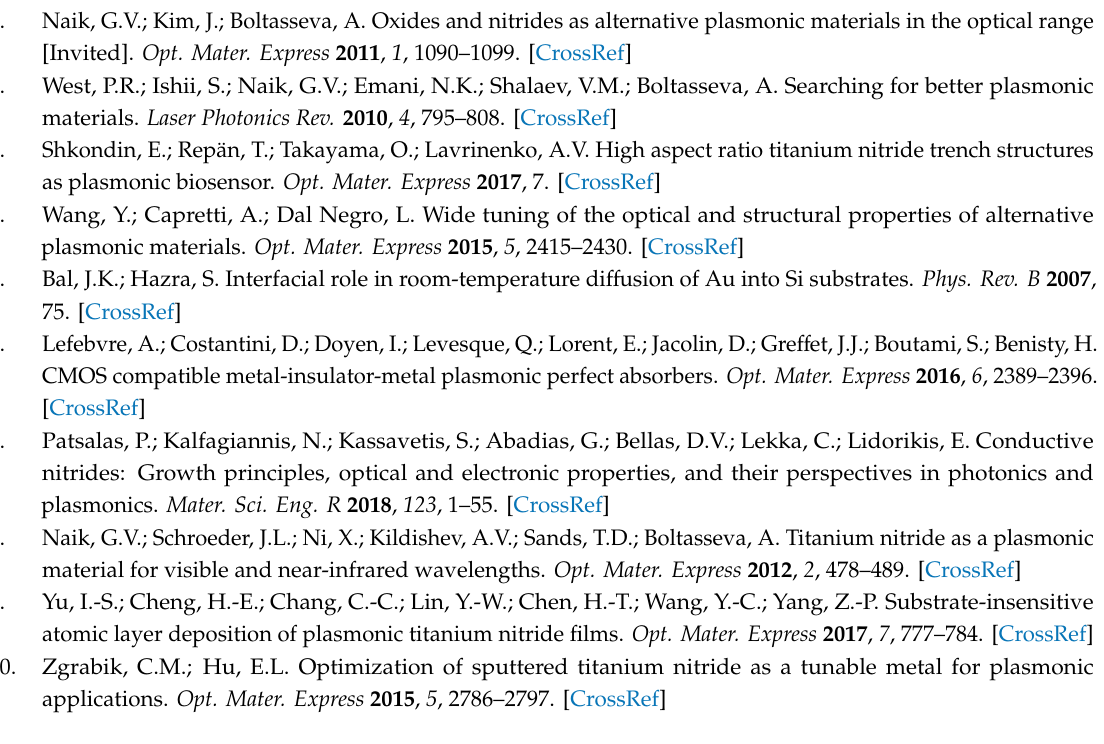
Figure S1: Raw XRR data of TiN films on Si (100) with varying the cycle number, Figure S2: Structural characterization of 100 ALD cycles TiN on Si after H 2 post-deposition treatment using